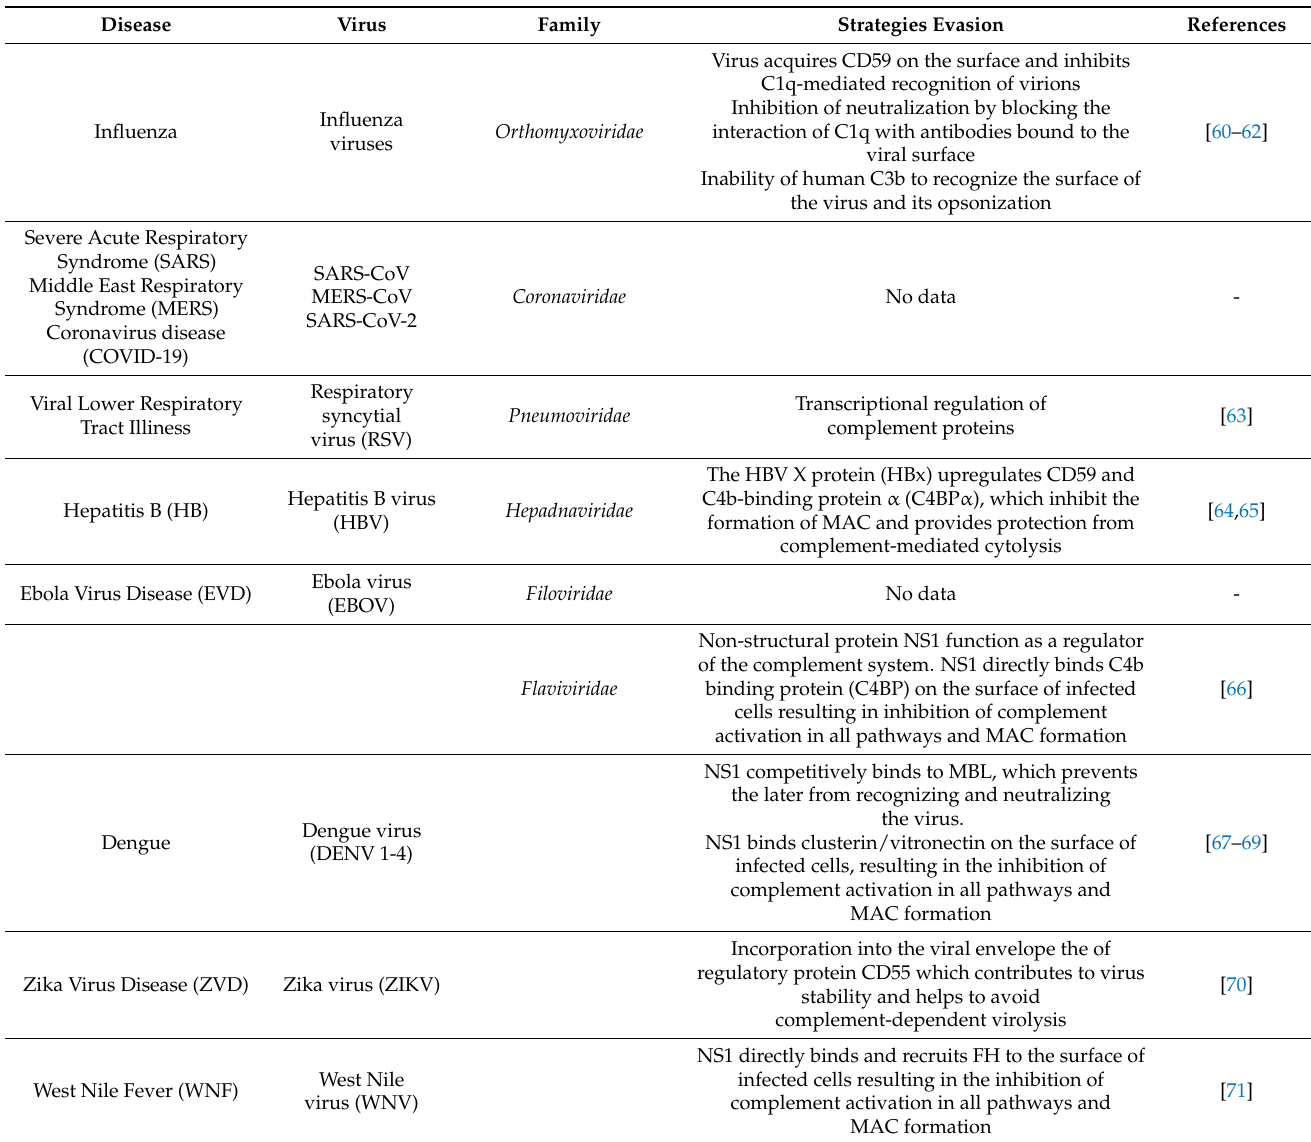
Table 2. Complement evasion strategies used by selected